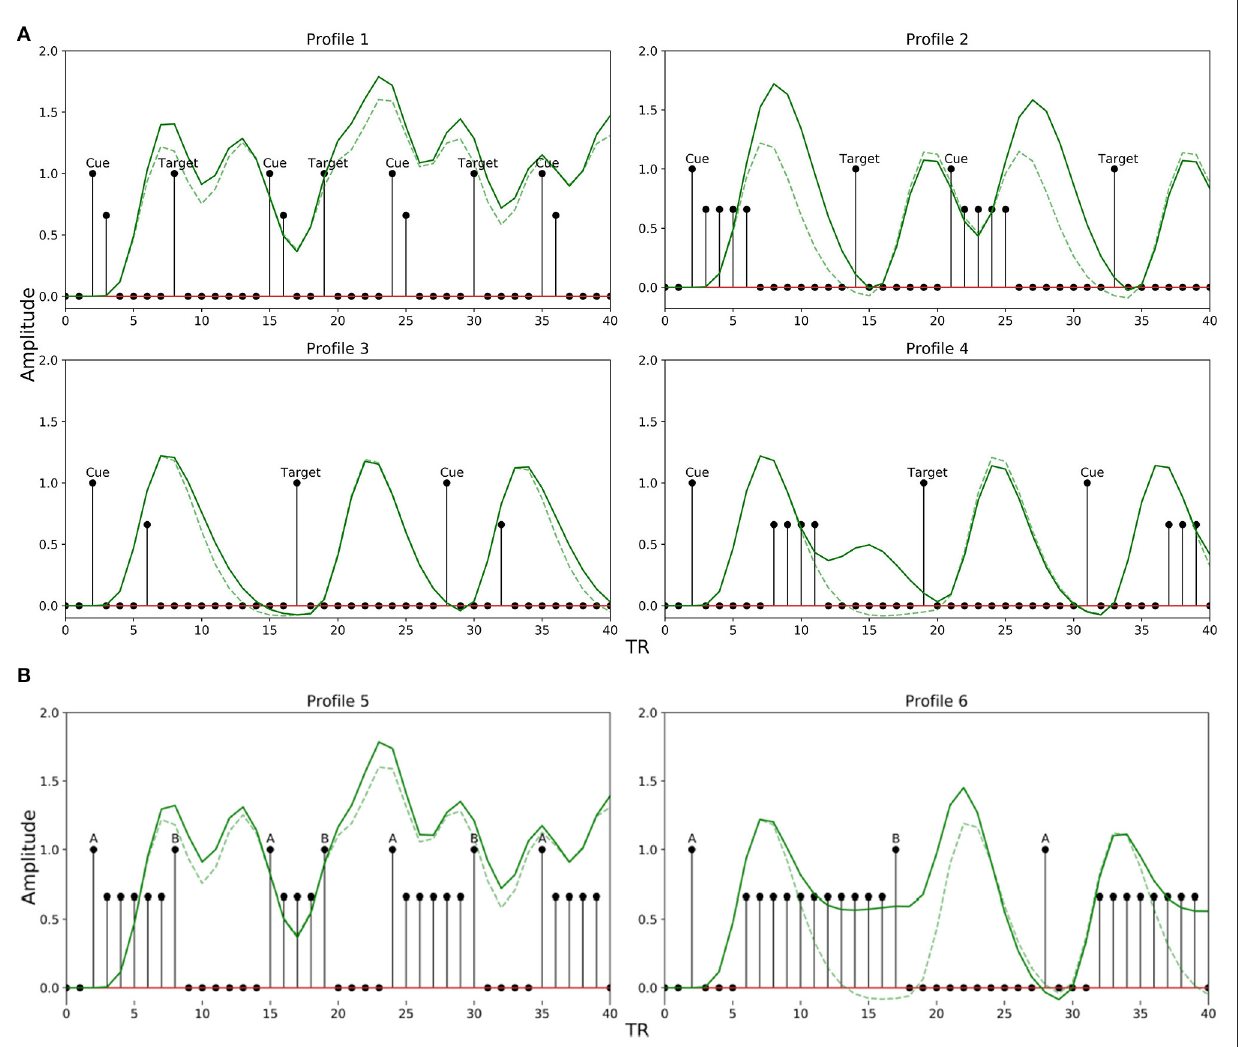
FIGURE4 Transient temporal profiles (TTPs) used in the simulation. (Solid Green Line: BOLD response in the presence of sub-impulse functions; Dotted Green Line: BOLD response in the absence of sub-impulse functions). (A) Profiles 1–4 was designed for an attentional control paradigm. (B) Profile 5 and 6 was designed for a working memory